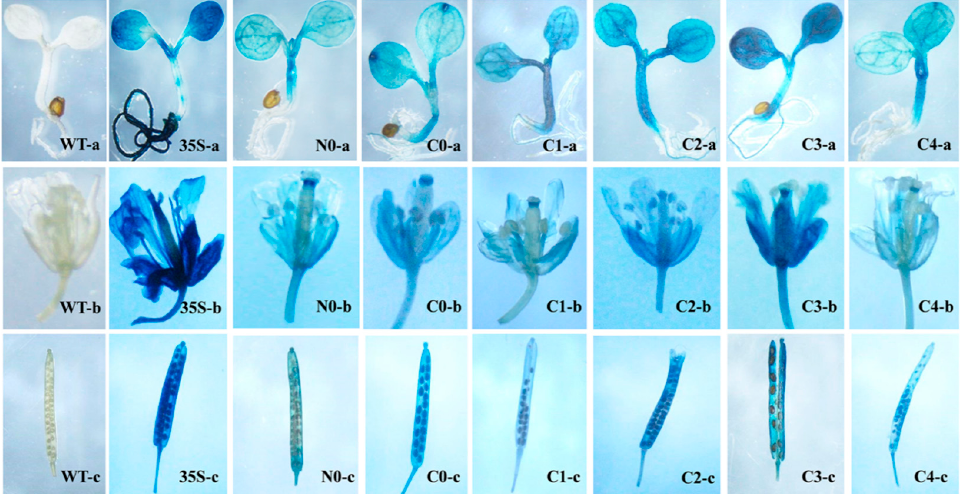
Figure 2. Histochemical staining of GUS activity. WT, wild-type Arabidopsis served as the negative control. 35S, lines containing the CaMV35S promoter served as positive controls. N0 and C0 were full-length promoter transformants of EhNcwINVP and EhCcwINVP , respectively. C1, C2, C3, and C4 were transformants carrying 5 ′ deletions of EhCcwINVP ( − 1460, − 729, − 612, and − 209 bp upstream of ATG, respectively). a: fi ve-day-old seedlings, b: flowers, c: silique pods.